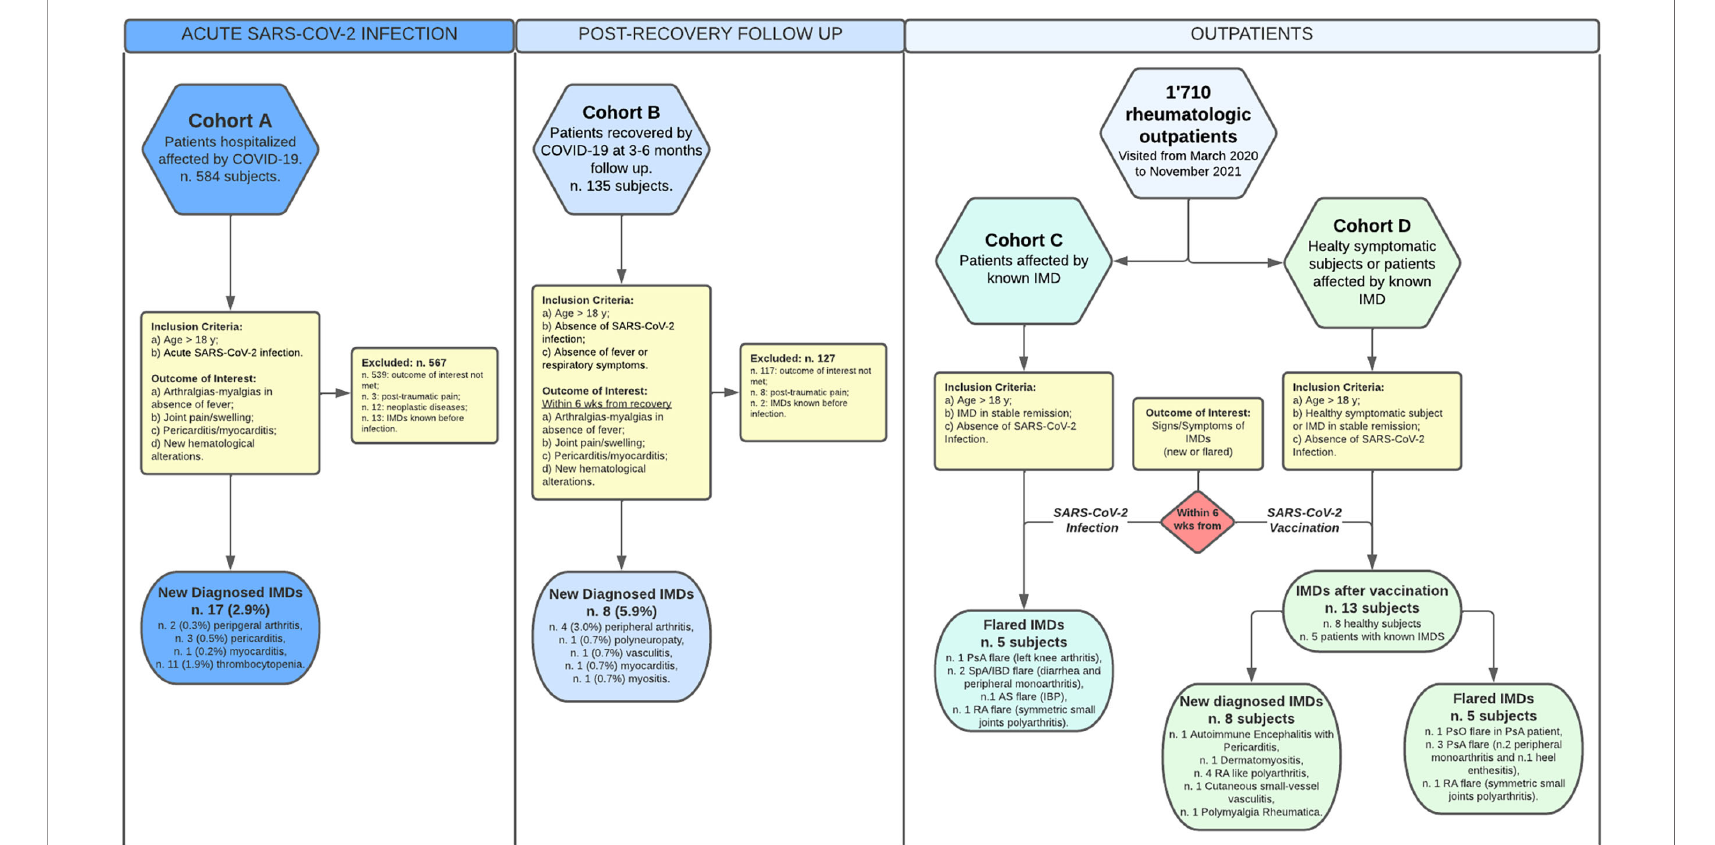
FIGURE 1 | Schematic representation of the study and patients ’ groups. In the fl ow chart are represented the composition of the patients ’ cohorts/groups, inclusion/exclusion criteria in the study and brief presentations of the clinical outcomes. All the patients who suffered of IMDs symptoms after the vaccination had been vaccinated with two boost doses of the vaccines listed in the Table 6 . For more details, see the Materials and Methods